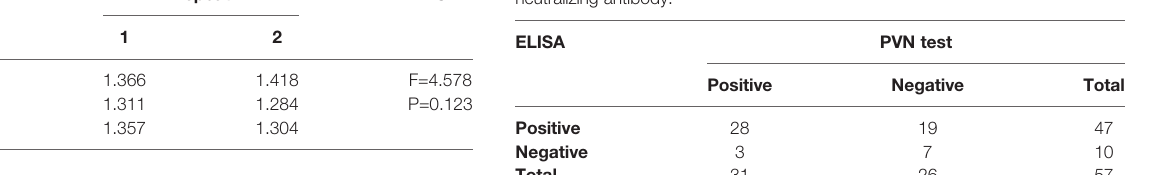
TABLE 3 | Determination of the agreement of indirect ELISA for the detection of anti-SARS-CoV-2 IgG antibody to neutralization assay for detection of neutralizing antibody.